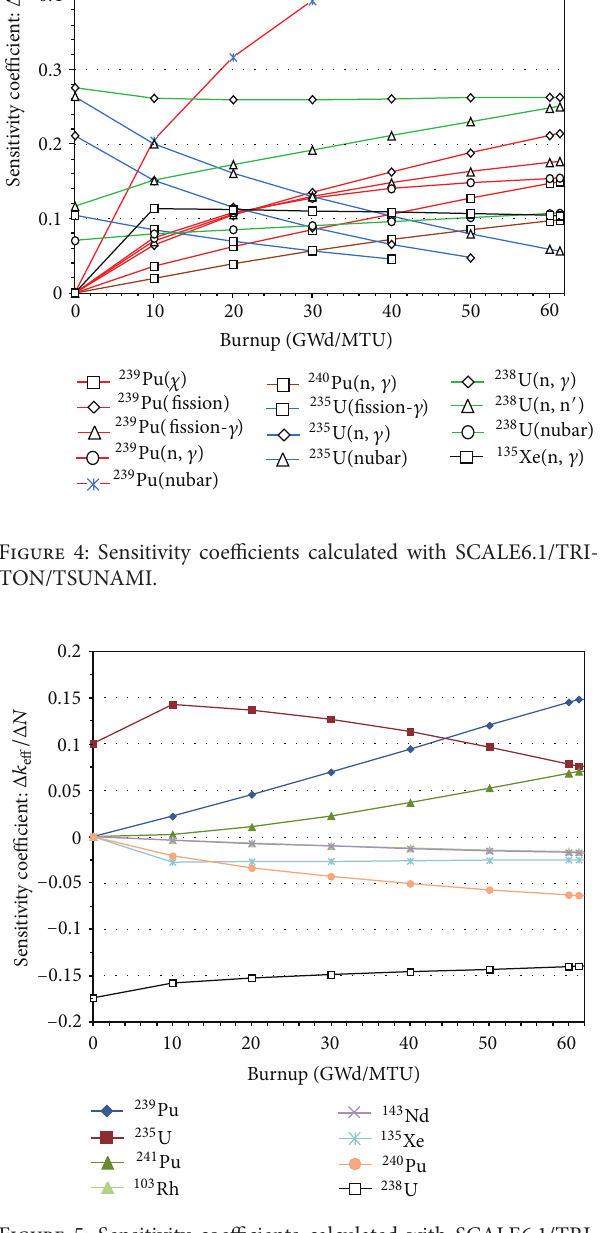
F 5: Sensitivity coefficients calculated with SCALE6.1/TRI-